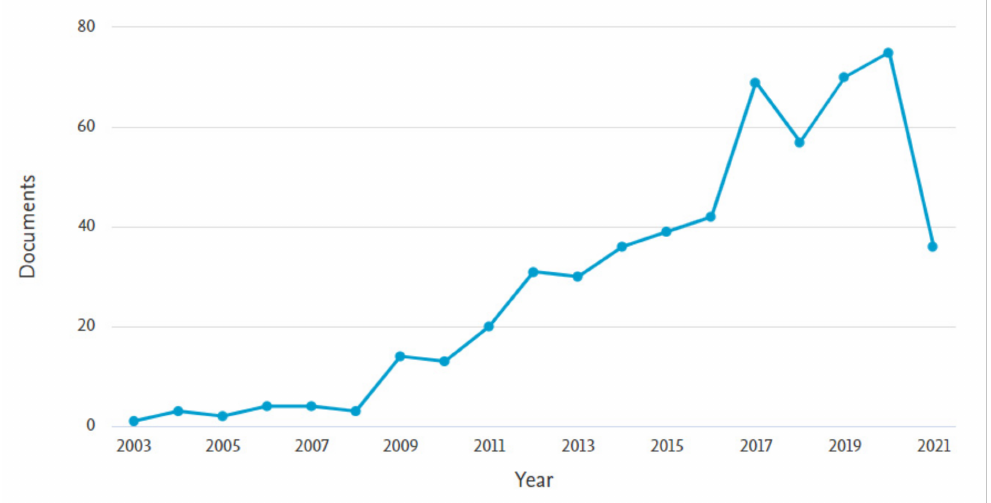
Figure 1. The number of annual publications on the topic of interest showing exponential growth (created using Scopus database